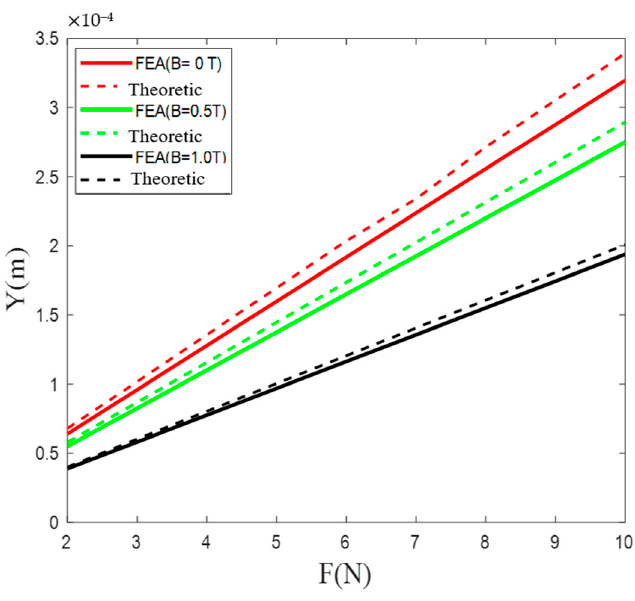
Figure 6. Load–displacement curves for different applied magnetic fields.